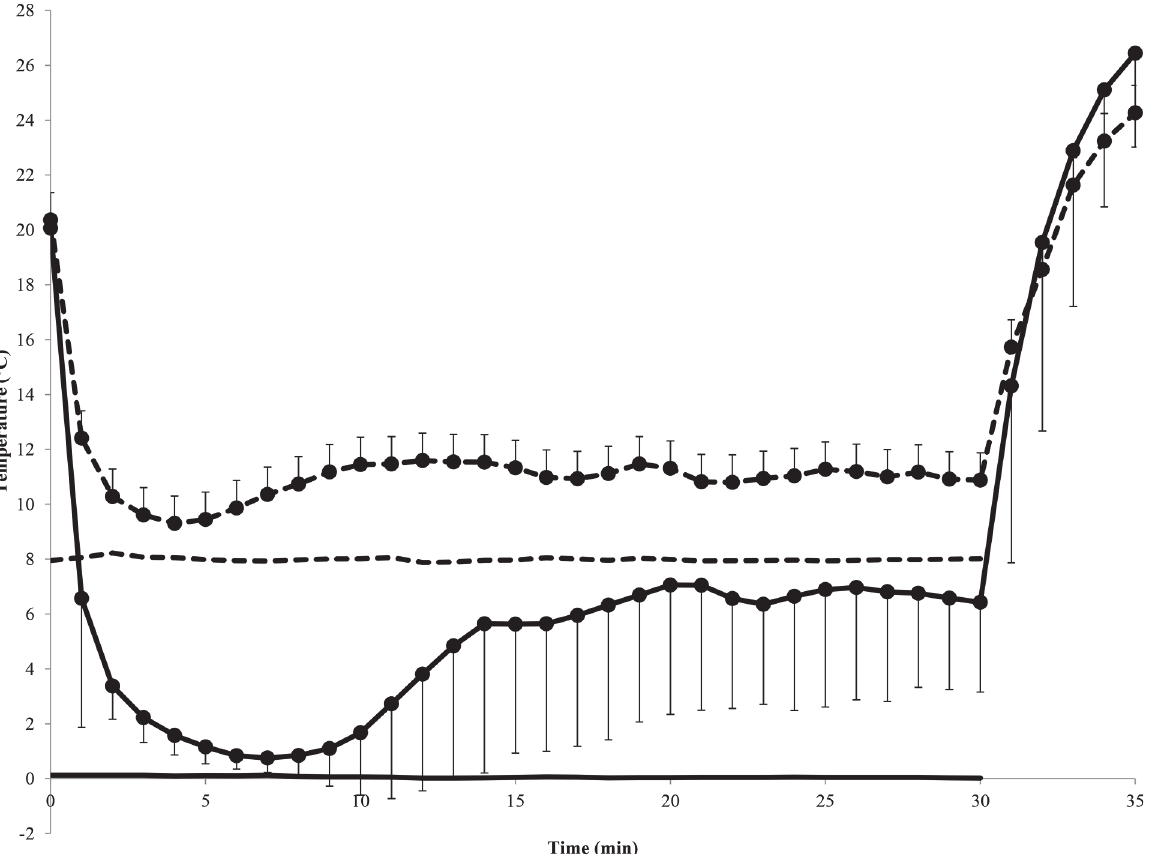
Fig 1. Mean ( ± SD) finger temperature during immersion and recovery and mean water temperature during immersion. Dashed line = 8°C trial; solid line = 0°C trial. Marker = finger temperature; no marker = water temperature.